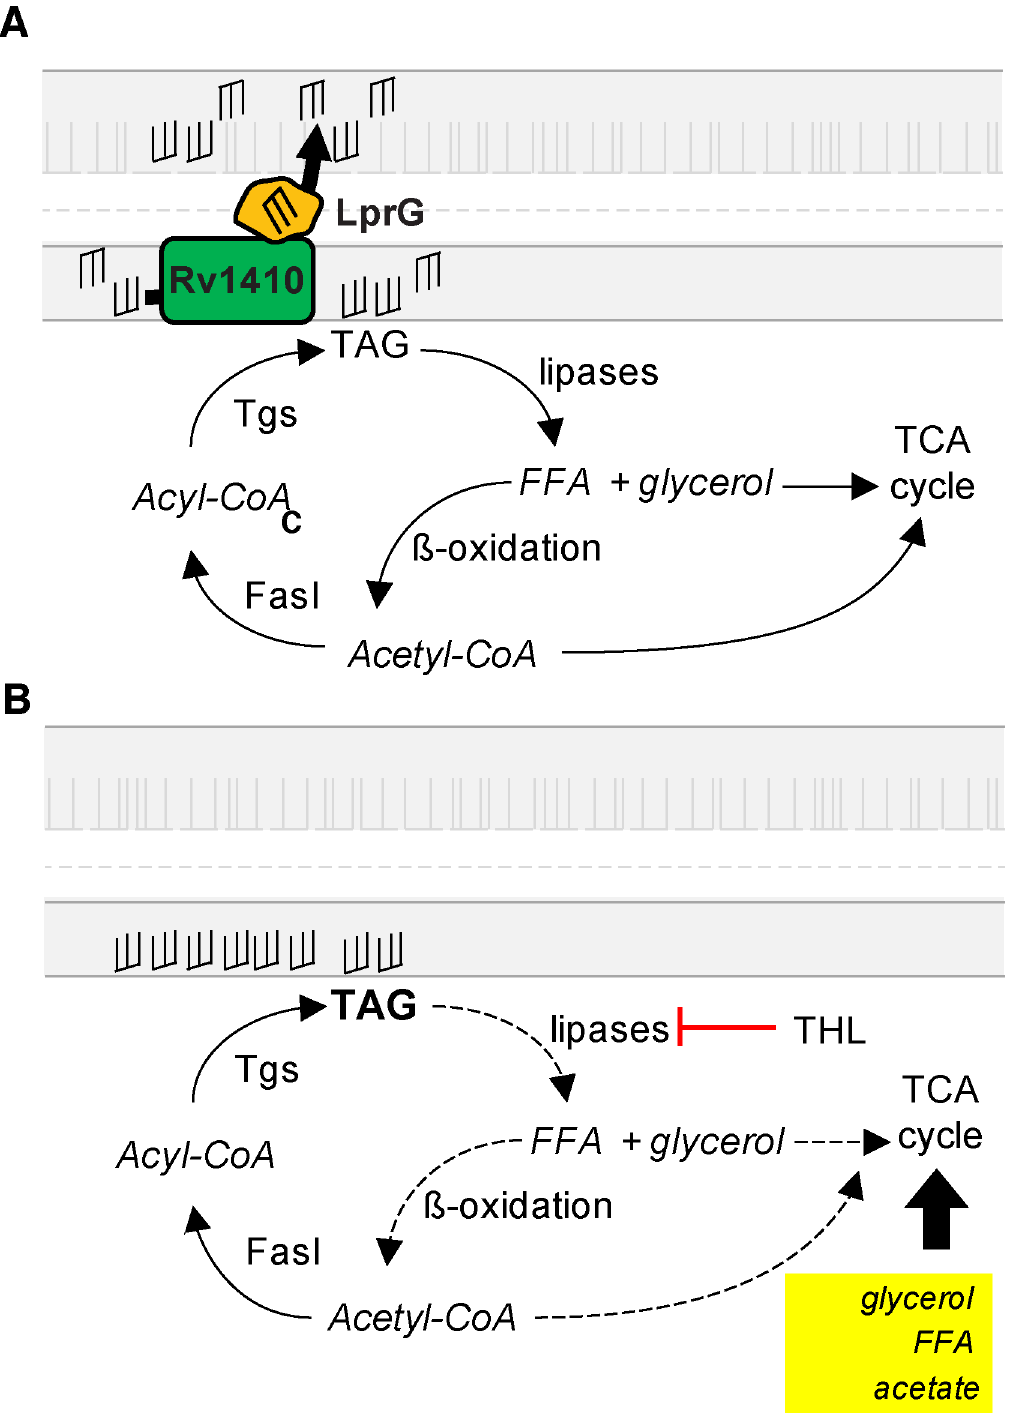
Fig 7. Model for the role of LprG-Rv1410-mediated TAG transport in regulating the growth rate of Mtb . (A) In the presence of a functional LprG-Rv1410, FasI makes acyl primers (acyl-CoA) for cell wall lipid synthesis (including TAG via TAG synthases, Tgs) . TAG can then be 1) incorporated into the Mtb cell wall via the action of LprG-Rv1410 or 2) hydrolyzed by lipases. Acetyl-CoA for anapleurosis of the TCA cycle is generated via β -oxidation of free fatty acids (FFA) liberated from TAG. (B) Loss of LprG-Rv1410 function results in increased intracellular TAG due to lack of transport into the cell wall. The presence of accumulated intracellular TAG may inhibit growth by a currently unknown mechanism. Decreasing lipolysis via lipase inhibitors further increases intracellular TAG levels. Addition of acetate, glycerol, or FFA bypasses the need for lipolysis by providing acetyl-coA that feeds into the TCA cycle and relieves growth